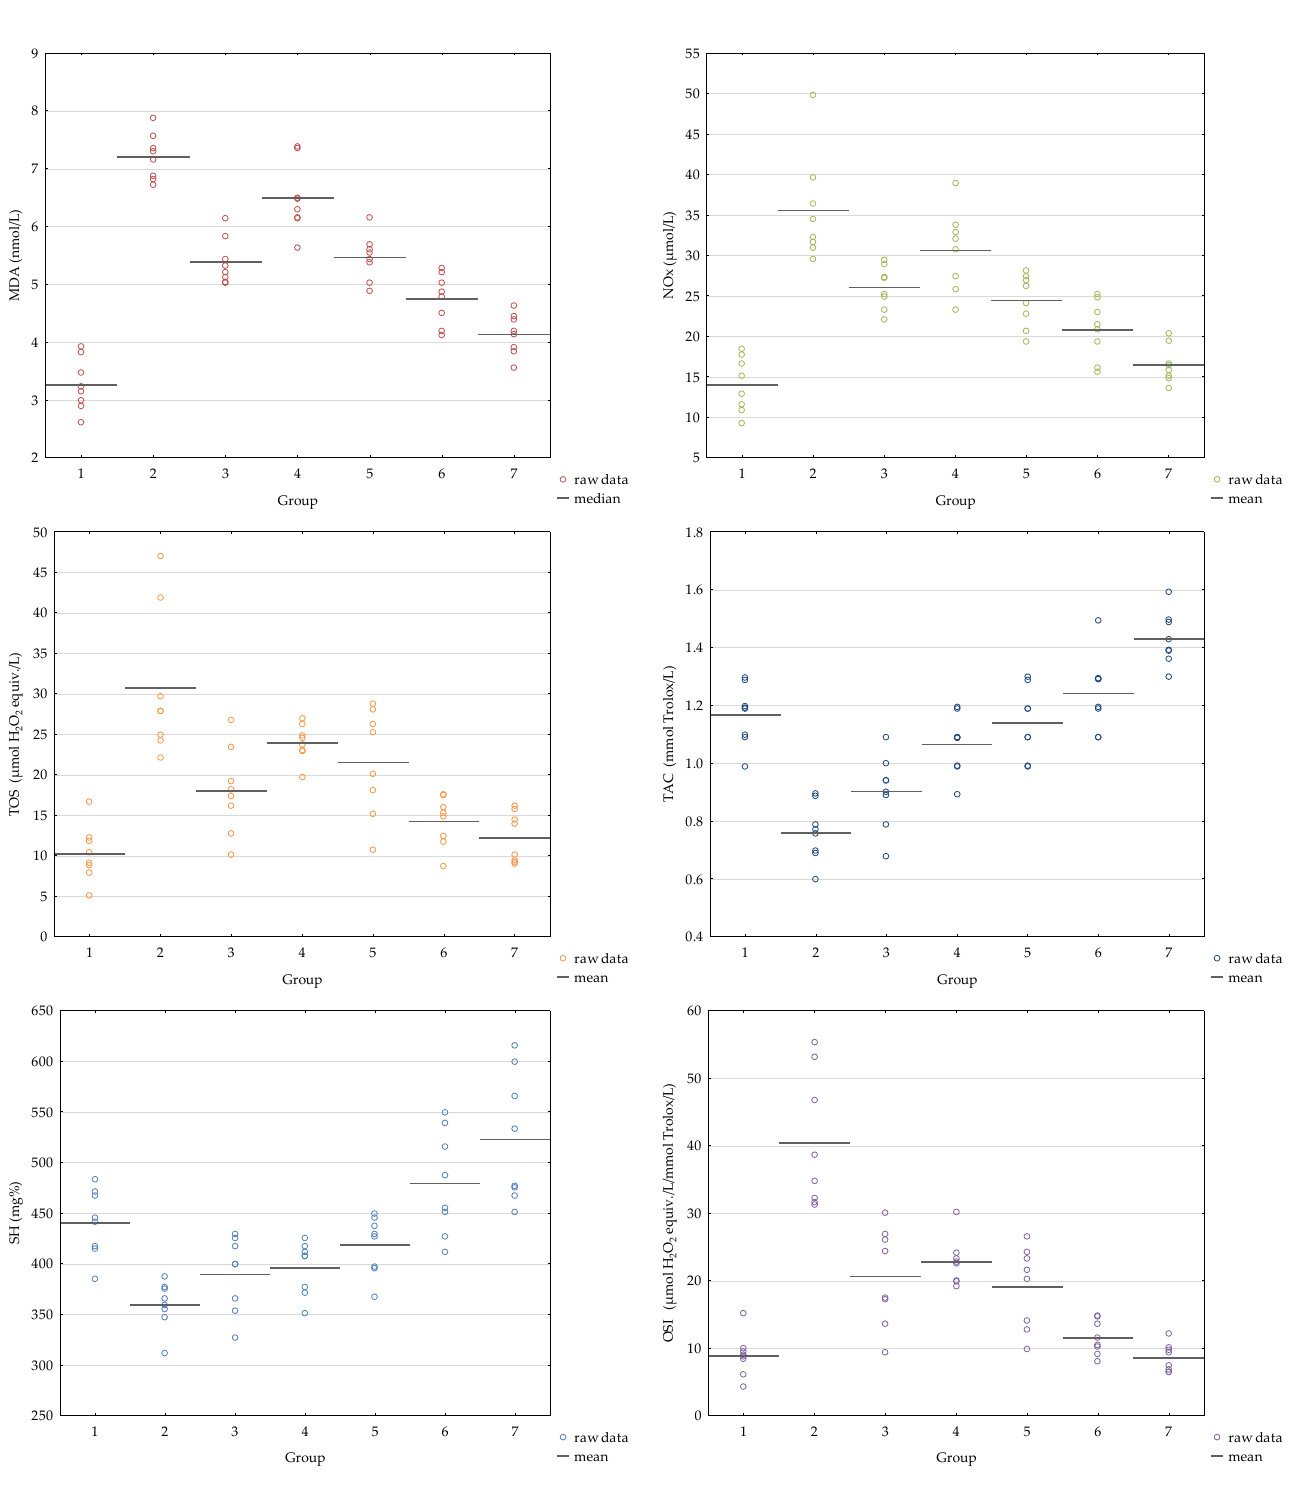
Figure 4. Variation of evaluated serum markers by group (1 = C, 2 = AI, 3 = AI-D, 4 = AI-GRCE100, 5 = AI-GRCE200, 6 = AI-GRCE100-D, 7 = AI-GRCE200-D).